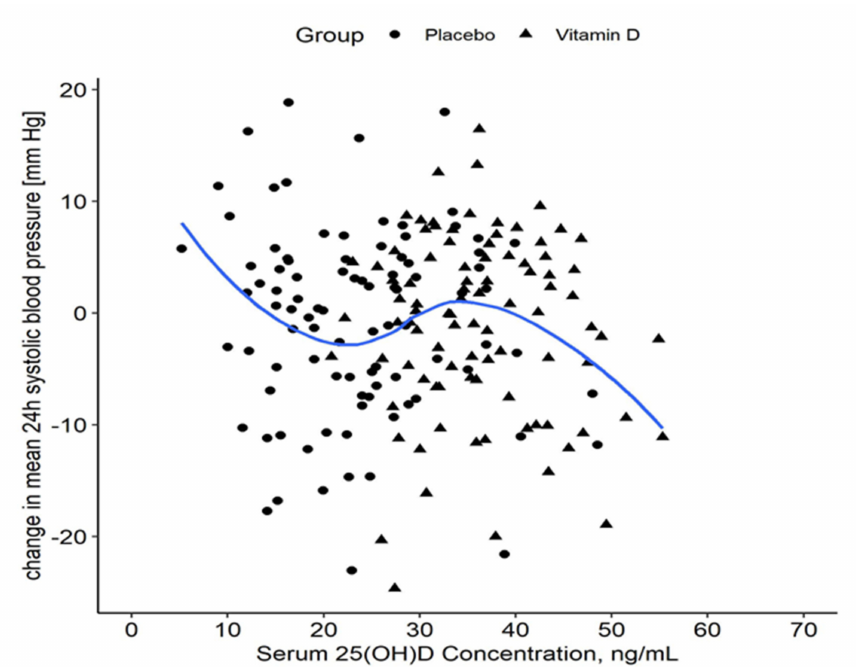
Figure 1. Change in 24-hour systolic blood pressure by serum 25(OH)D concentration. The LOESS curve visualizes a possible non-linear relationship of change in 24-hour systolic blood pressure at 8 weeks from baseline as a function of achieved 25(OH)D. The shaded area represents the 95% CI bands. The total sample size is n = 200. LOESS—locally estimated scatterplot smoothing; 25(OH)D— 25-hydroxyvitamin